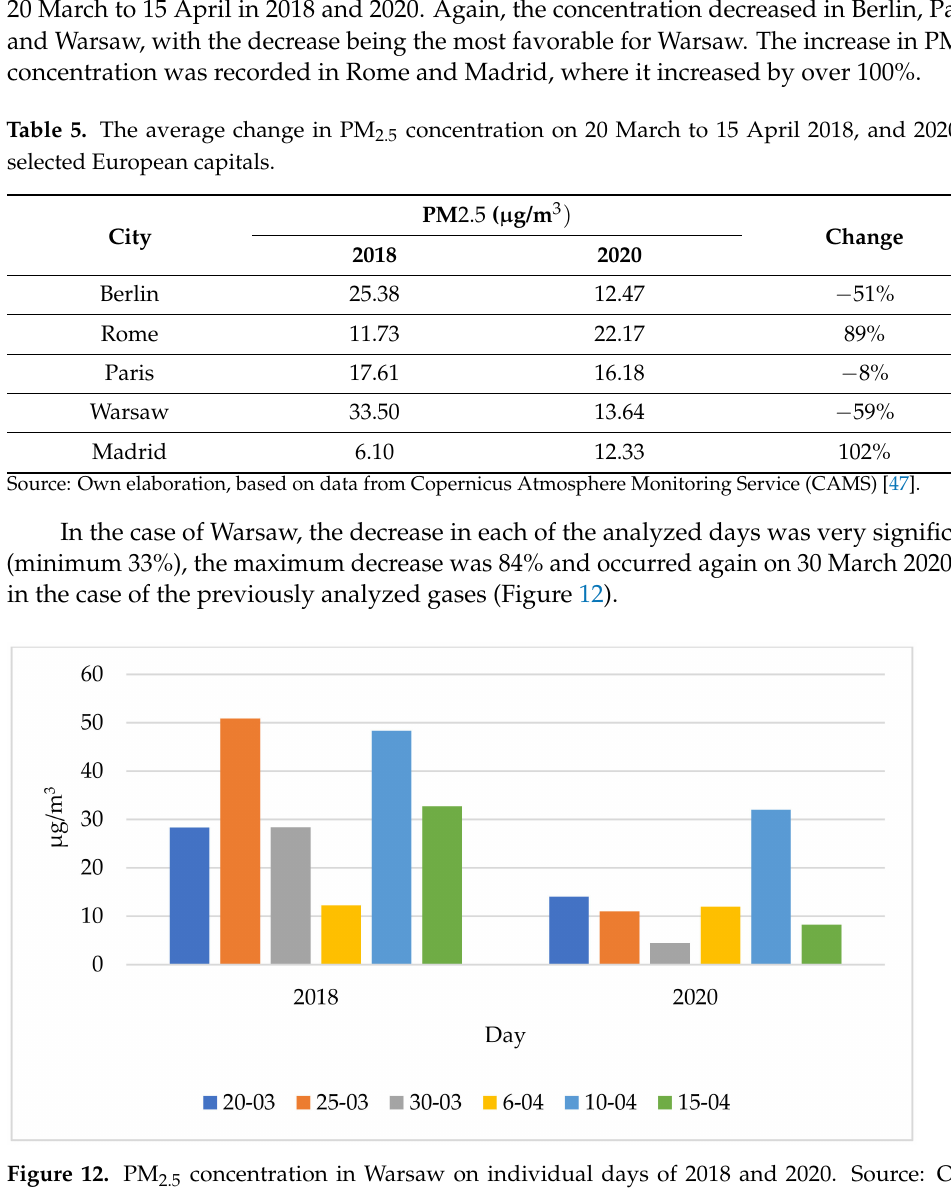
Figure 12. PM 2.5 concentration in Warsaw on individual days of 2018 and 2020. Source: Own elaboration, based on data from Copernicus Atmosphere Monitoring Service (CAMS)